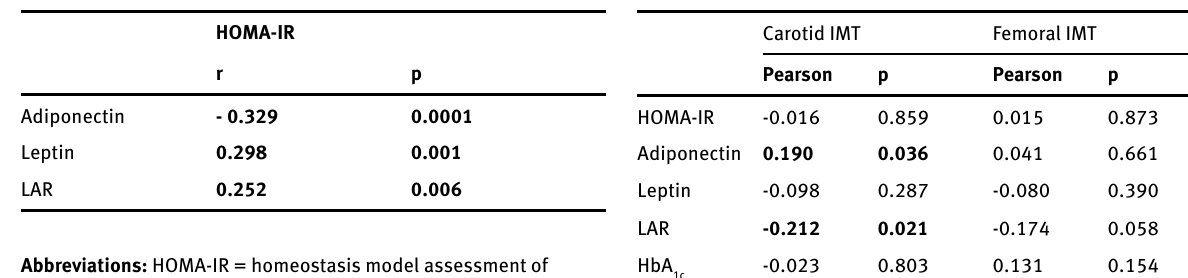
Table 3: Correlations between HOMA-IR and adipokine values Table 4: Correlations of IMT values with the metabolic